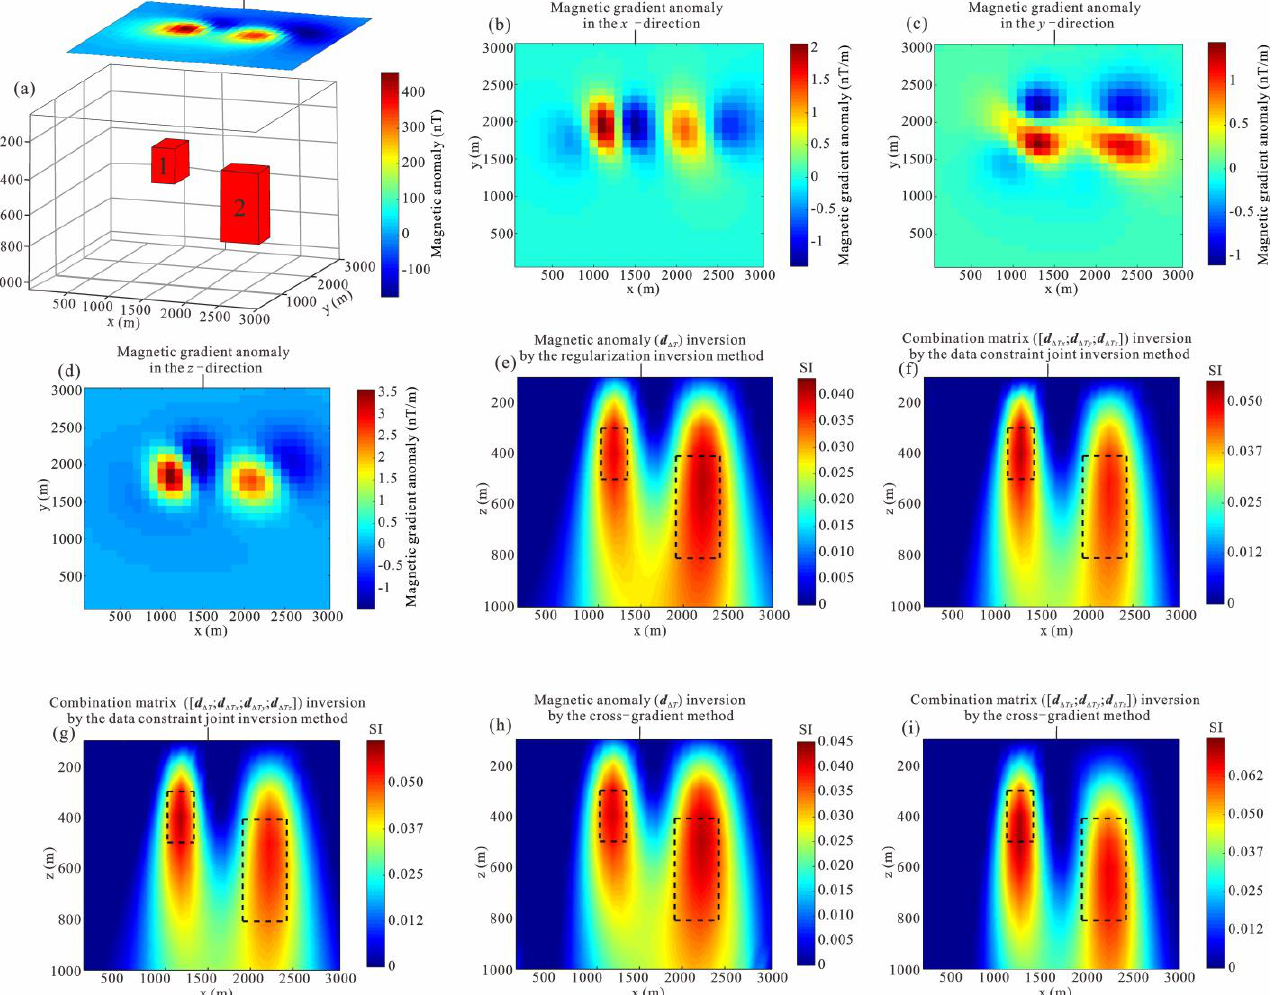
d ). ( f ) Magnetic susceptibility slice (cid:104) (cid:105) T  d ∆ T ; d ∆ T ; d ∆ T ). ( g ) Magnetic susceptibility slice x y z  ddd ). (cid:104) (cid:105)  d ∆ T ; d ∆ T ; d ∆ T ; d ∆ T ). xy z TTT  x y z